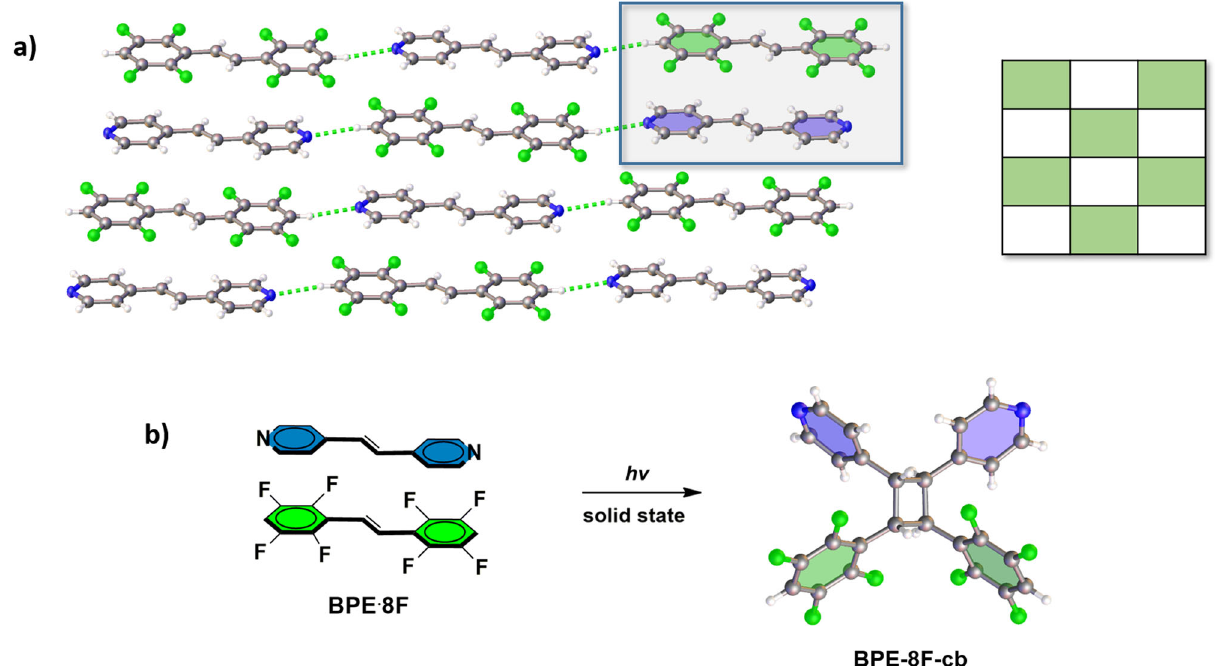
Fig. 5 Cross-photoreaction showing X-ray structures. a BPE ˑ 8F (inset: representation of packing type), b BPE-8F-cb with solid-state photoreaction